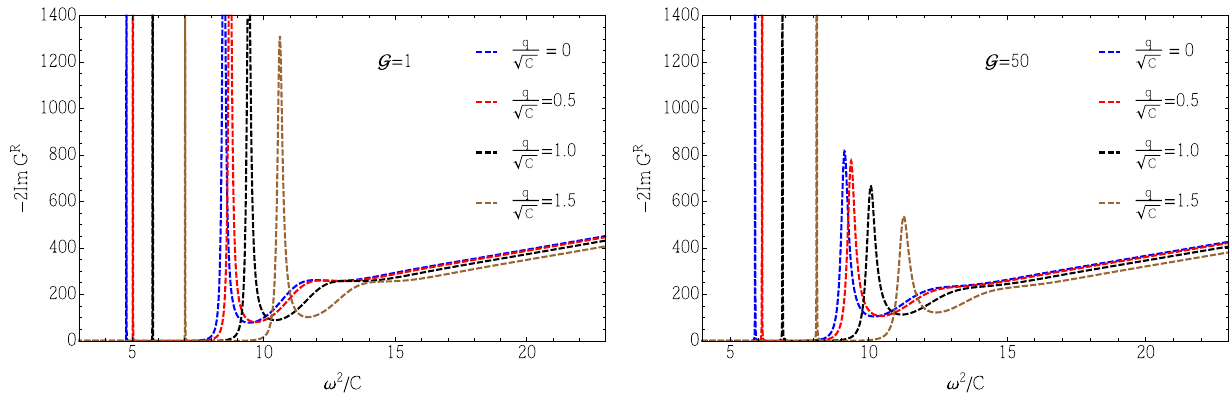
Fig. 8 Spectral functions with different wavenumber values for G = 1 (left panel) and G = 50 (right panel), in both cases we set (cid:10) T = 0 .